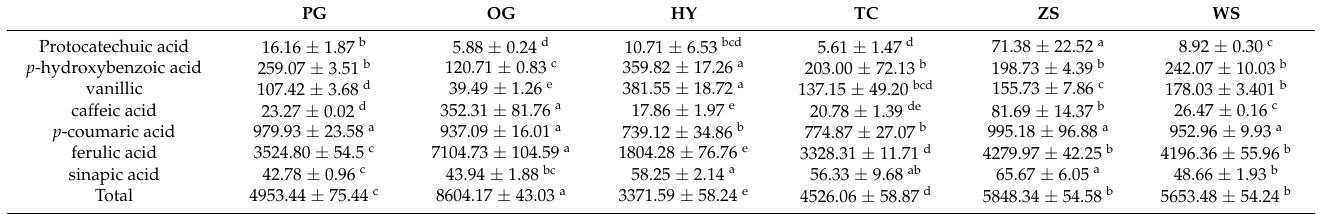
Table 1. Soluble phenolic acids contents in young fruits of citrus from different varieties ( µ g/g